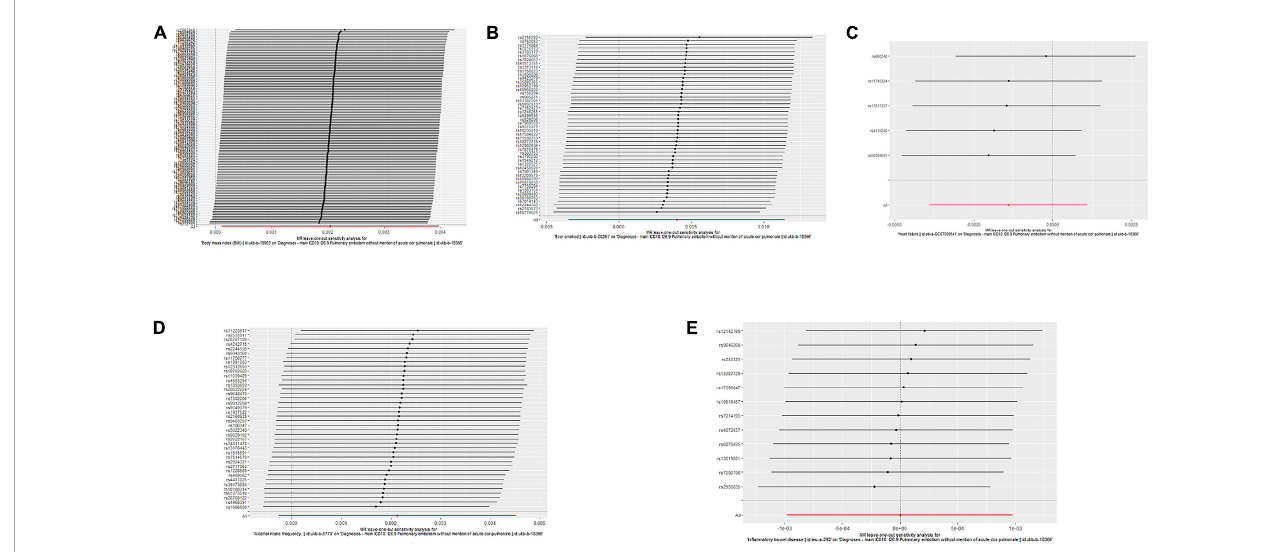
FIGURE2 “Leave-one-out” analysis shows the effects of body mass index (BMI), ever smoking, heart failure, frequency of alcohol intake, and inflammatory bowel disease (IBD)-related single nucleotide polymorphism (SNPs) on pulmonary embolism (PE). Mendelian randomization (MR) estimated effect sizes for BMI (A) , ever smoking (B) , heart failure (C) , frequency of alcohol intake (D) , and IBD (E) are shown. Data are expressed as β values and 95%